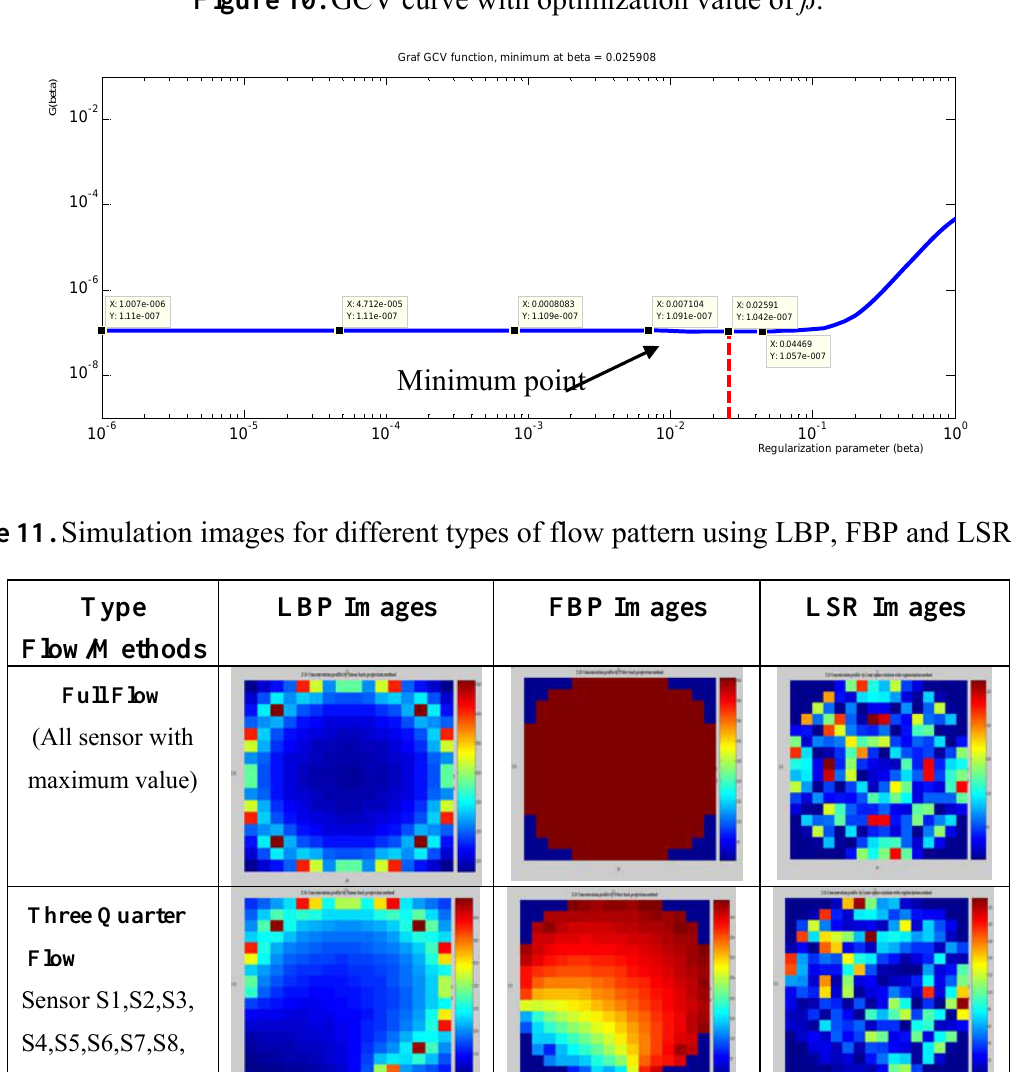
Figure 10. GCV curve with optimization value of ß .